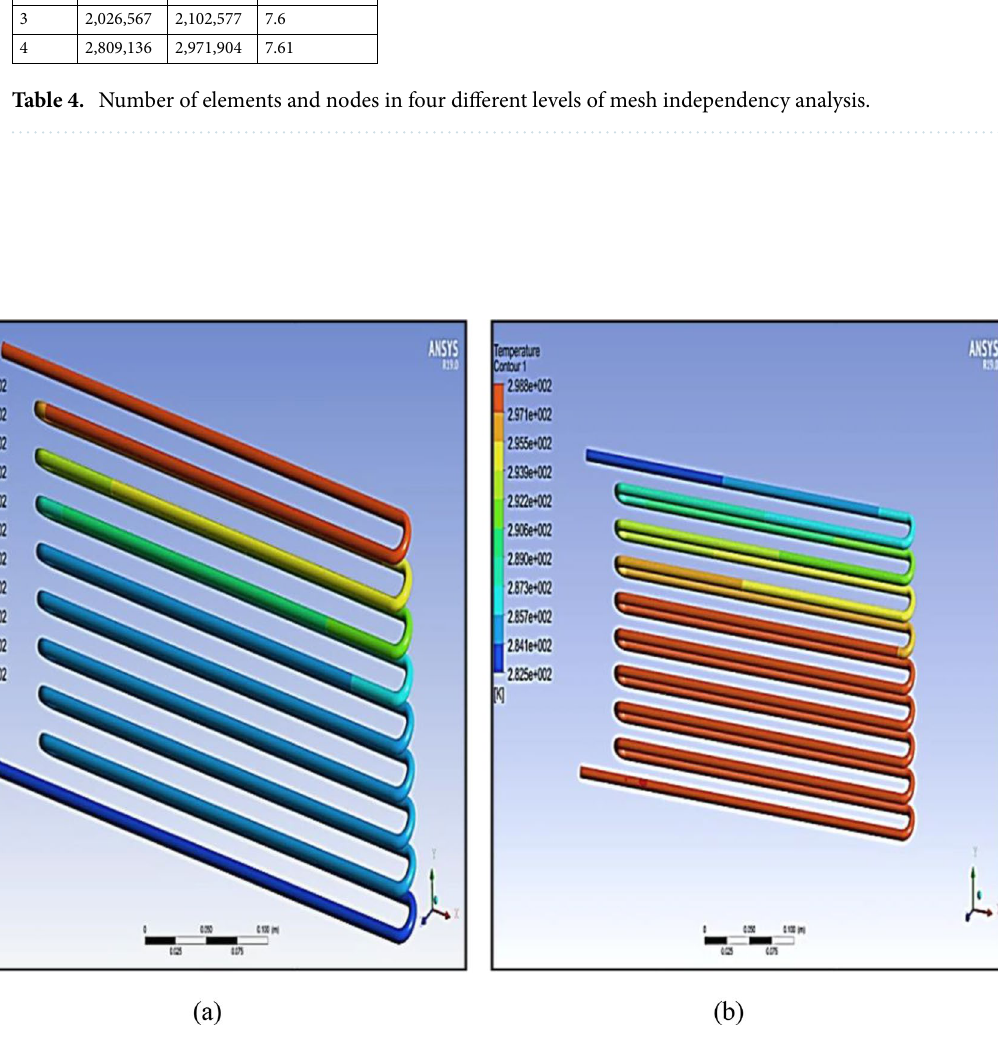
Figure 4. ( a ) The thermal gradient of the condenser and ( b ) the thermal gradient of the of the